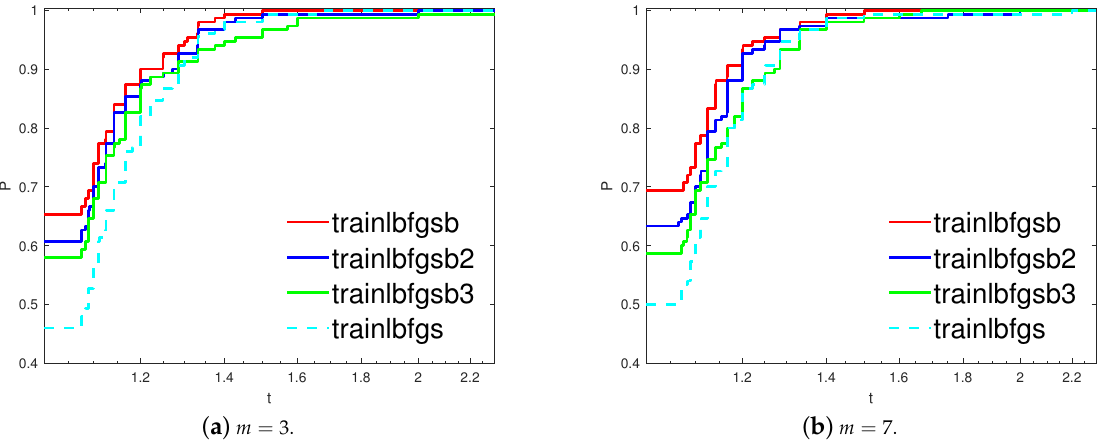
Figure 3. Log 10 scaled performance profiles based on accuracy for the Australian credit card classi- fication problem.